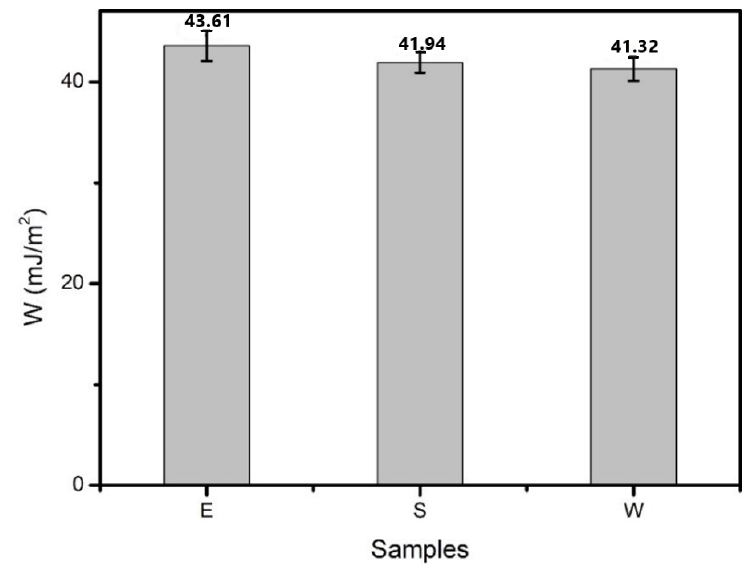
Figure 7. Wetting work of the three kinds of healing agents.